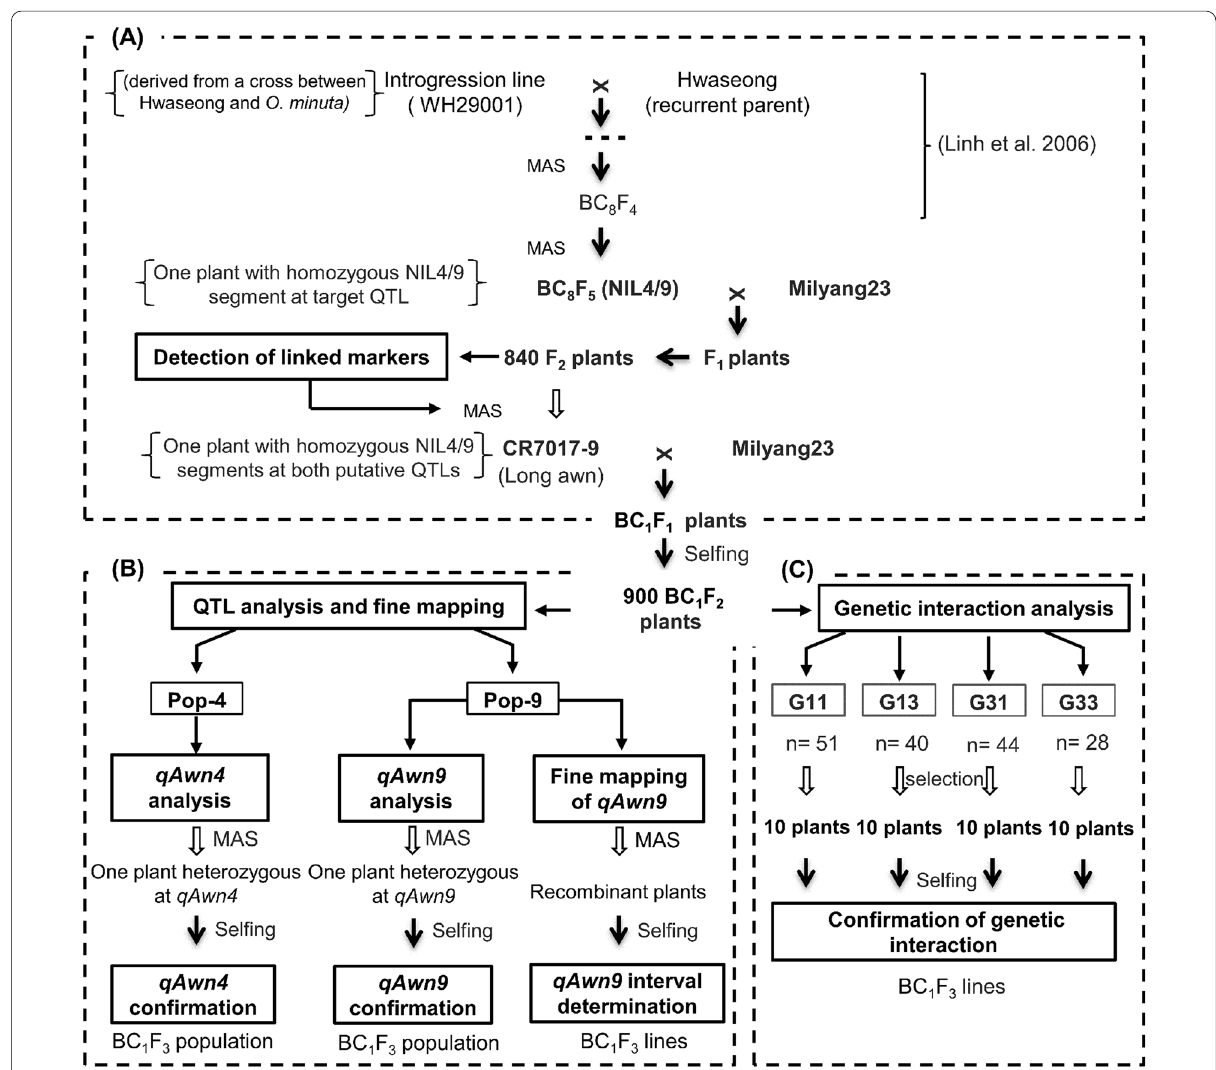
Fig. 2 Schematic of the experimental strategy used to perform QTL mapping. A Development of the F 2 population from a cross of NIL4/9 and Milyang23. An F 2 plant was chosen and crossed to Milyang23 to produce BC 1 F 1 plants. B Flow diagram of population development to map two QTLs, qAwn4 and qAwn9, and to fine map qAwn9 . Each BC 1 F 2 plant was chosen to map qAwn4 and qAwn9 . Recombinant plants in the qAwn9 region were selected and advanced to BC 1 F 3 lines for fine mapping of qAwn9 . C Four groups with different gene combinations of qAwn4 and qAwn9 were selected to analyze the interaction of two